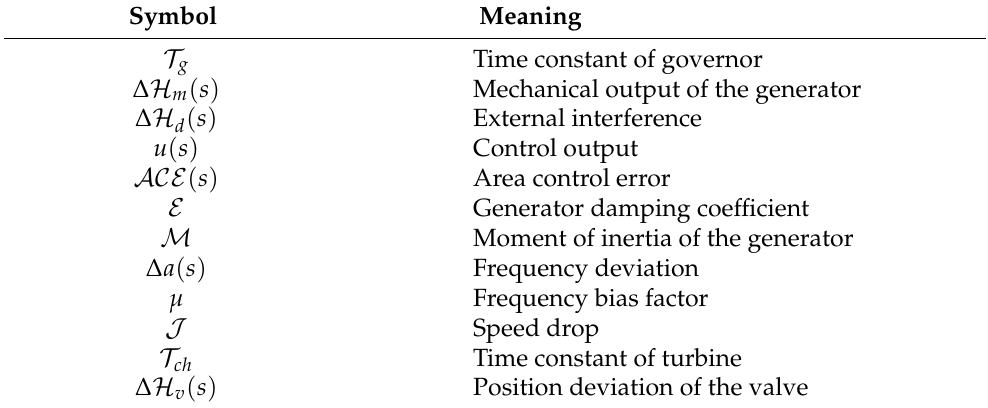
Table 1. Meanings of the symbols for the LFC